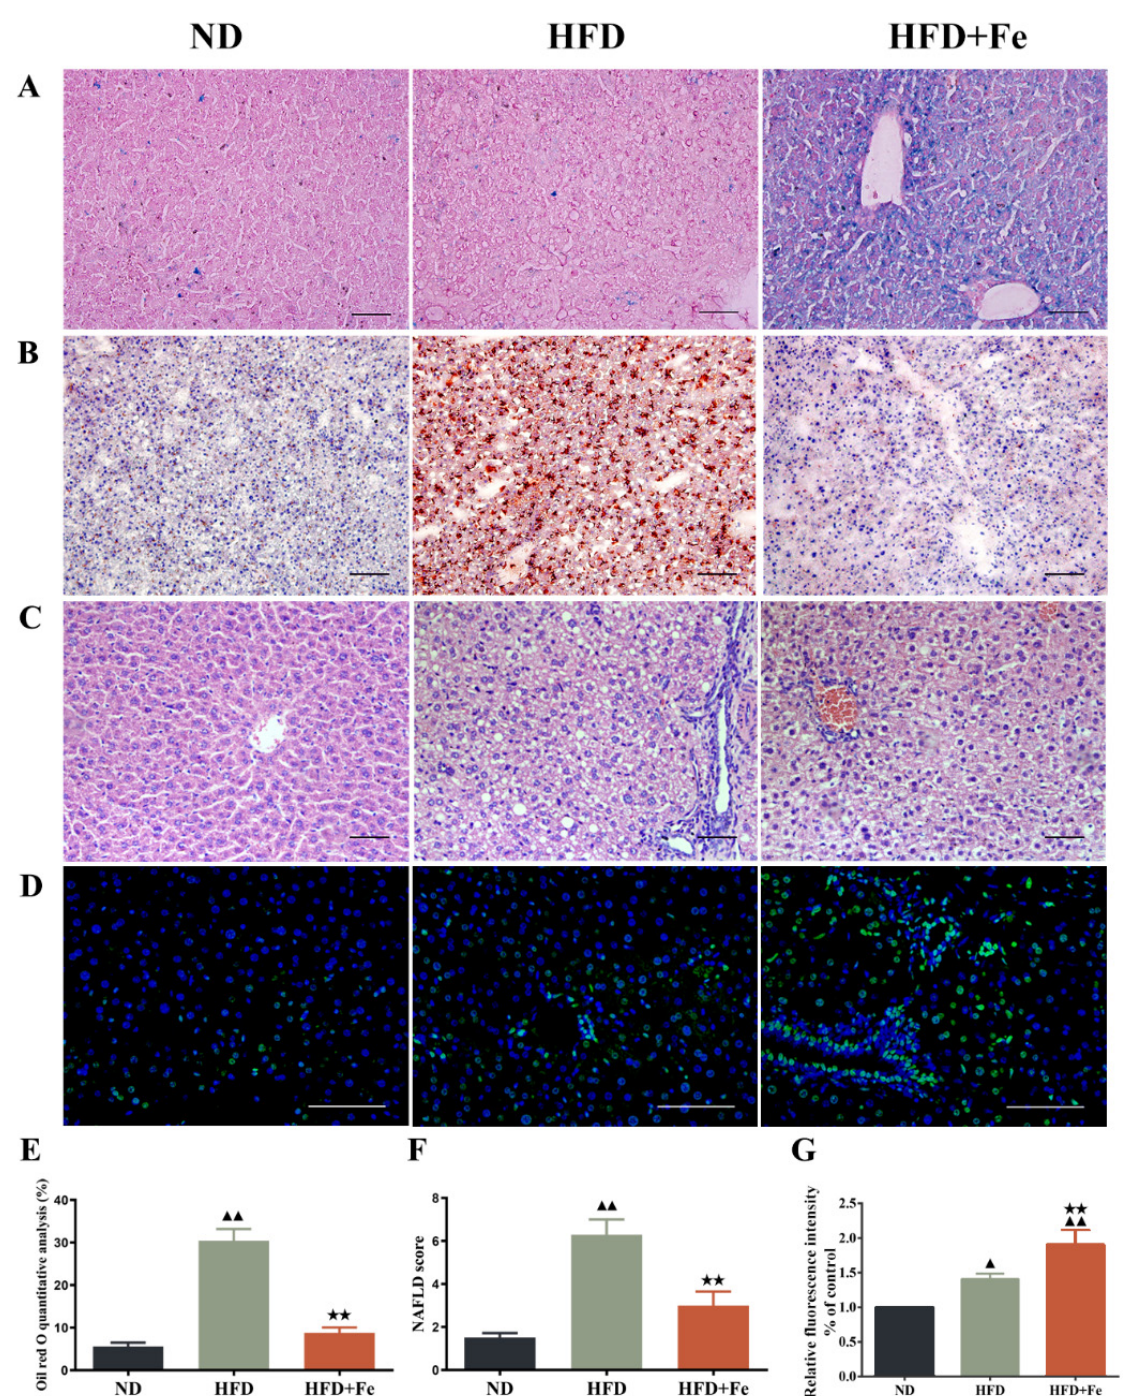
Figure 1. Histopathological observation of mouse liver. Six-week-old female ApoE knockout C57BL/6J mice (18–20 g) were randomly divided into three groups ( n = 12 per group) and fed a normal chow diet (ND), high-fat diet (HFD), or HFD supplemented with 2% carbonyl iron (HFD + Fe) for 16 weeks. The liver tissue samples were collected from 4 mice randomly selected from each group and subjected to Prussian blue staining ( A ), Oil red O staining ( B ), H&E staining ( C ), and TUNEL staining ( D ). ( E ) Quantification of B. ( F ) NAFLD scores based on H&E staining. ( G ) Quantification of ( D ). Scale bar: 50 µ m. Data were expressed as the mean ± standard deviation (SD). ▲ p < 0.05 vs. ND; ▲▲ p < 0.01 vs. ND; ★★ p < 0.01 vs. HFD. n = 4. ND: normal diet; HFD: high ‐ fat diet, HFD + Fe: high ‐ fat diet supplemented with 2% carbonyl iron.